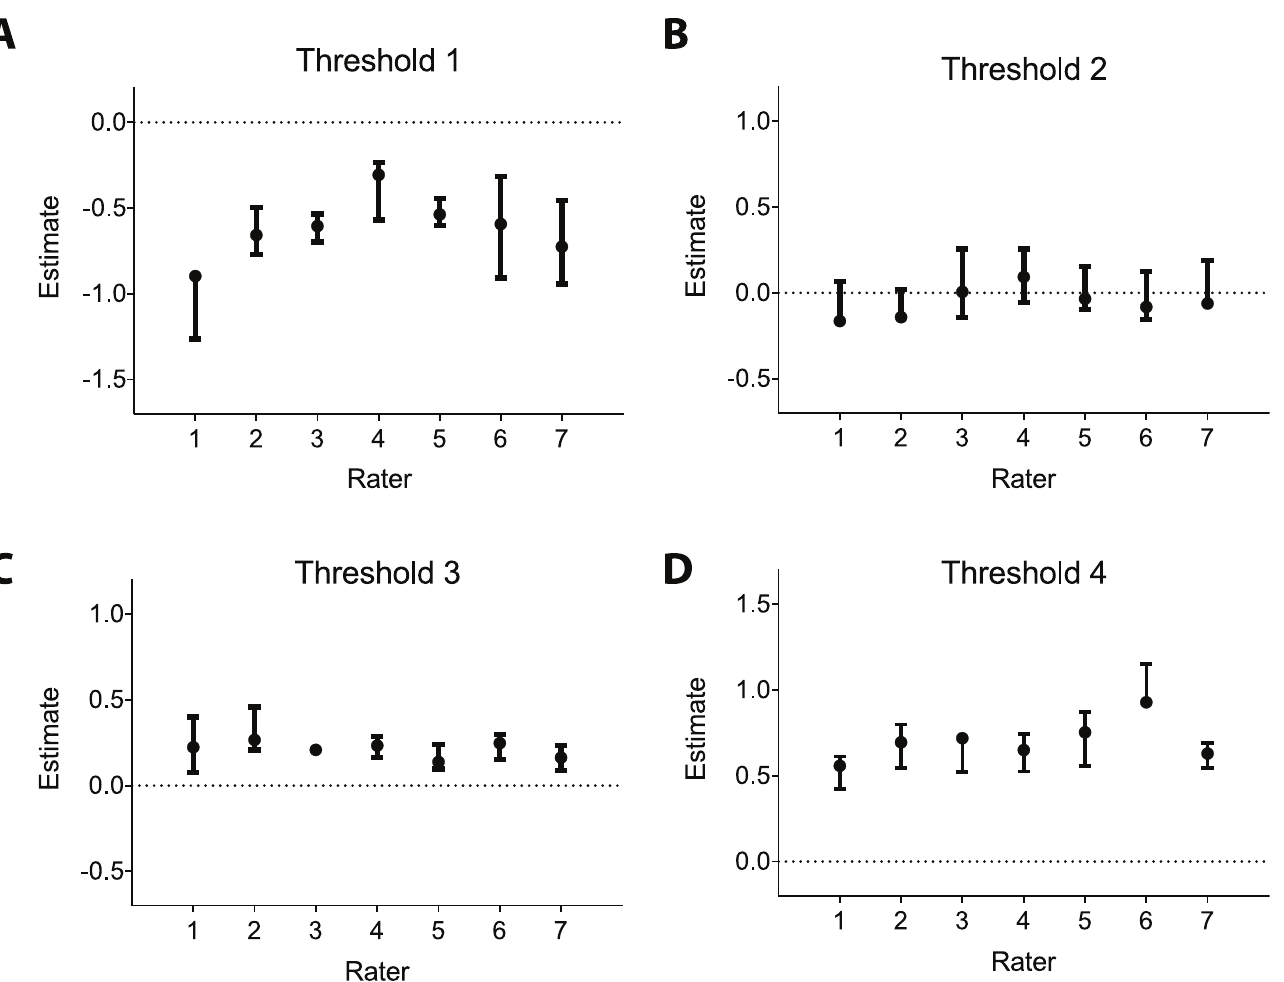
Fig 5. Rater-specific thresholds estimated using the common factor model. The thresholds classify the worms into the L1, L2, dauer, L3, or L4 stages. Each stages represents an abstract concept encompassing size, morphologic, and behavioral features of the worm that can be perceived by a rater relative to each threshold. Threshold 1 (A) separates the L1 and L2 categories, threshold 2 (B) separates the L2 and dauer categories, threshold 3 (C) separates the dauer and L3 categories, and threshold 4 (D) separates the L3 and L4